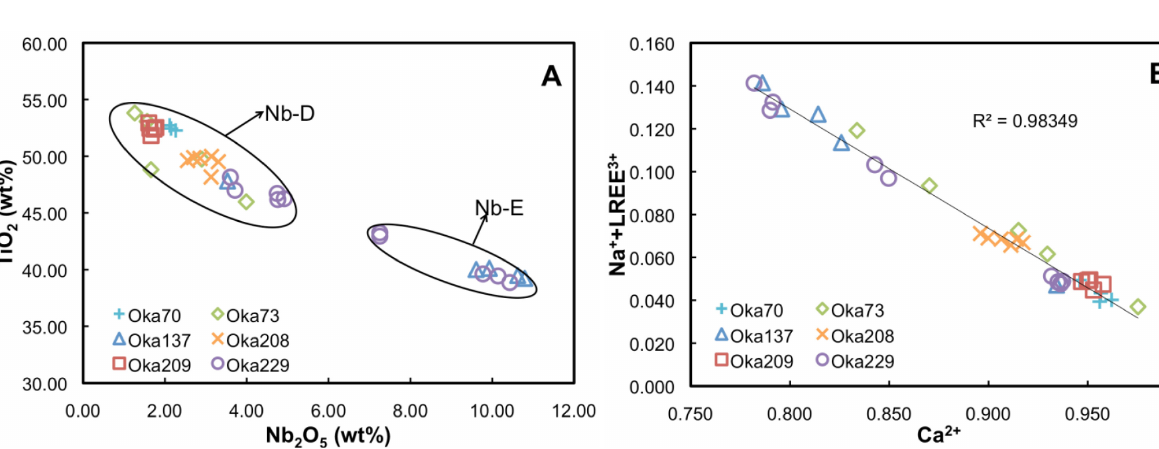
Figure 4. Compositional variation diagrams for perovskite from Oka. ( A ) TiO with Nb-E and Nb-D groups identified; ( B ) (Na + + LREE 3+ ) vs. Ca 2+ ; ( C ) (Al 3+ + Fe 3+ + Nb 5+ ) vs. Ti 4+